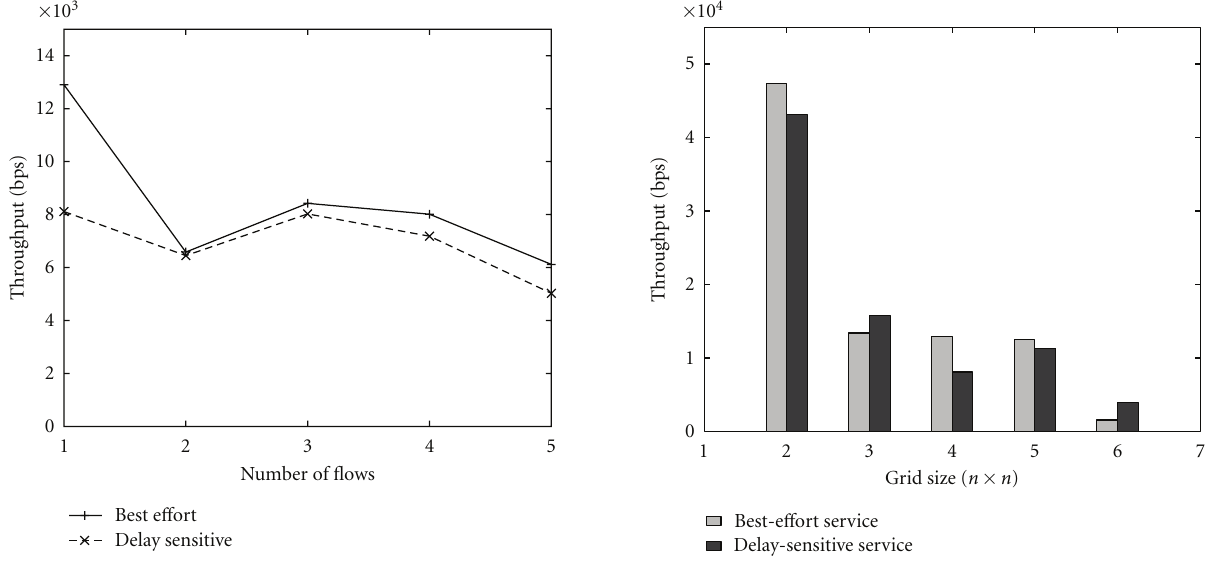
Figure 9: Throughput comparison: delay sensitive versus best e ff ort services.